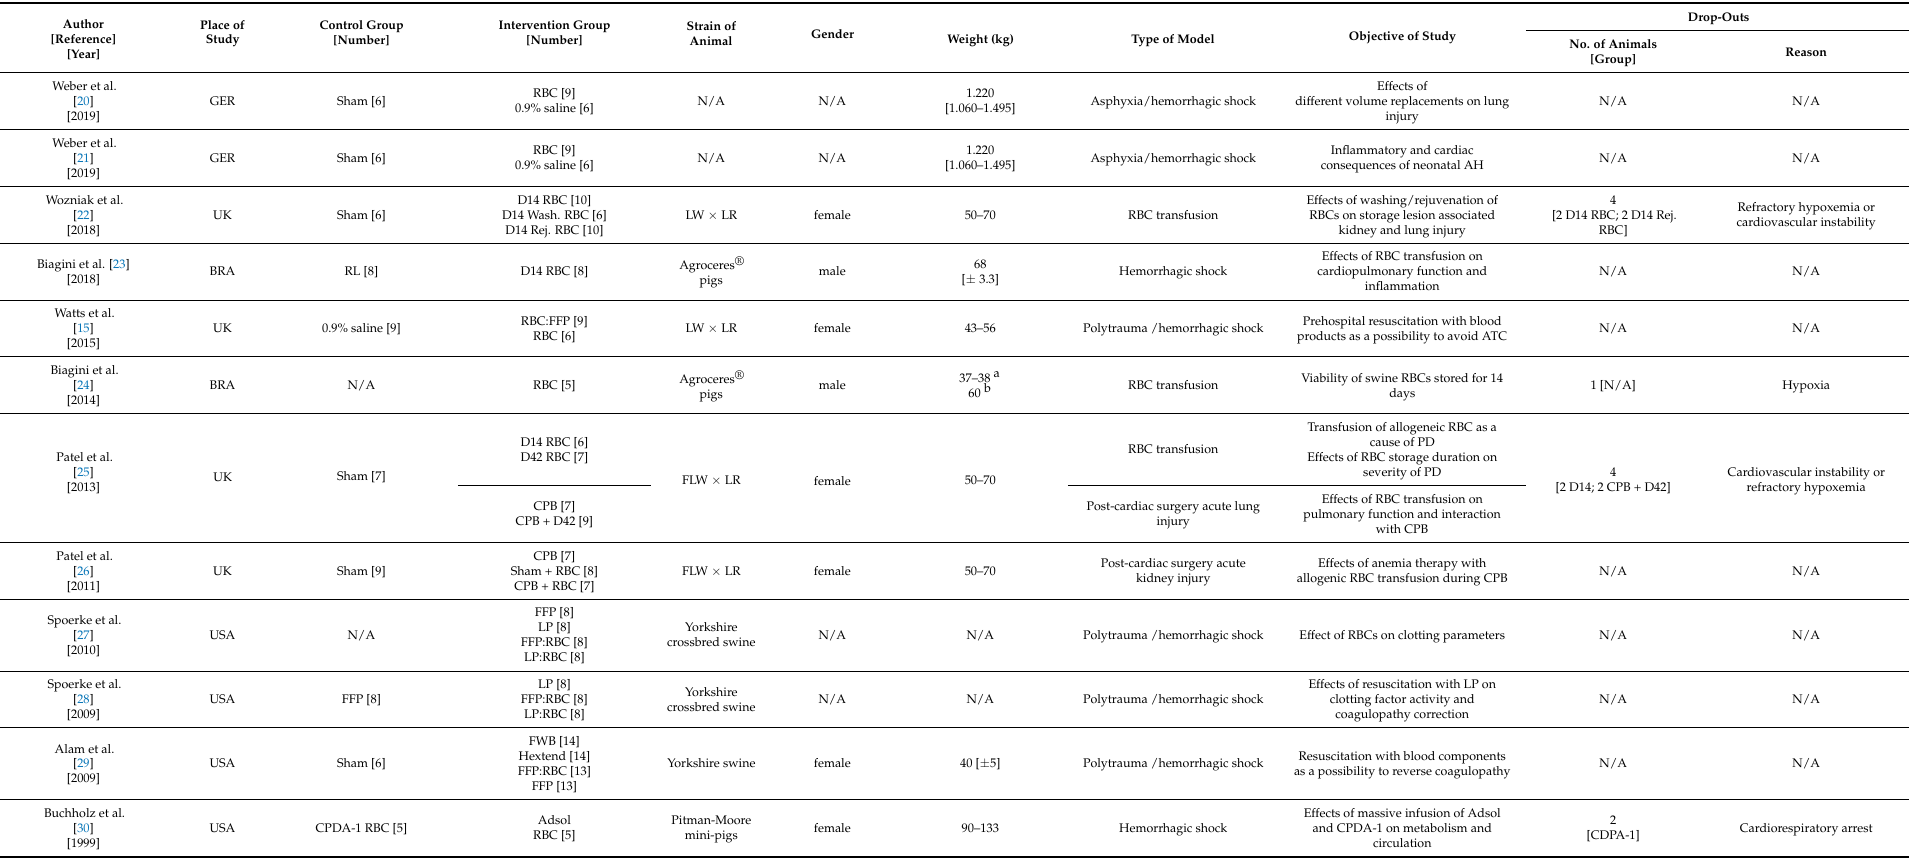
Table 1. Characteristics of included porcine studies (group A), sorted by year of